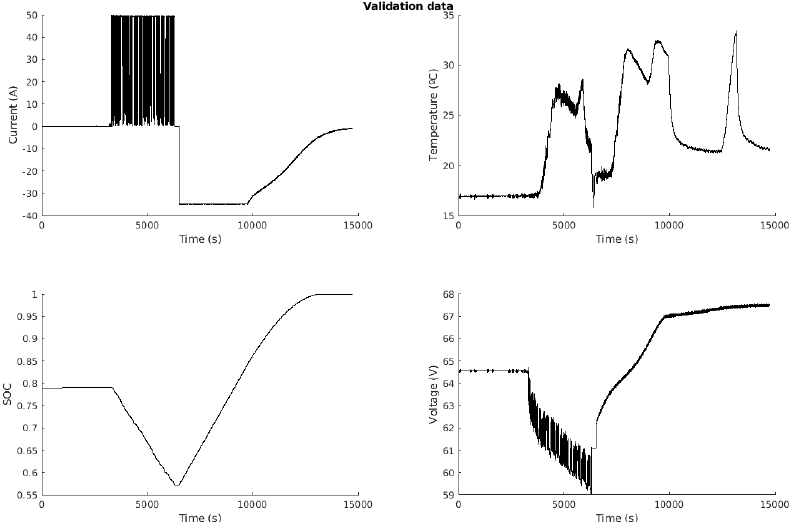
Figure 10. Validation data.